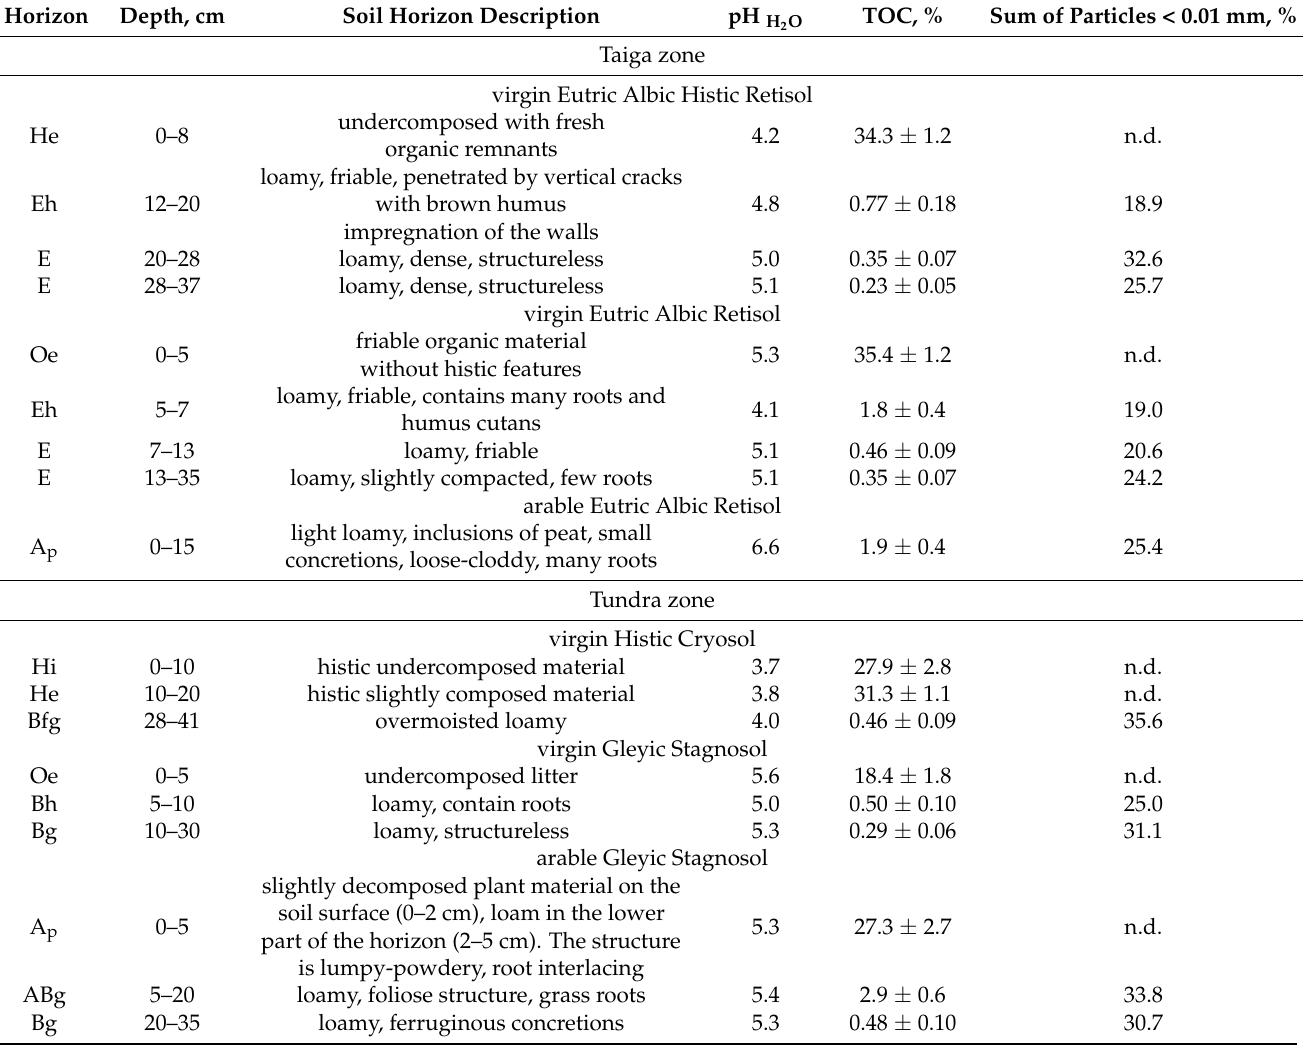
Table 2. The morphological descriptions and the physicochemical properties of the